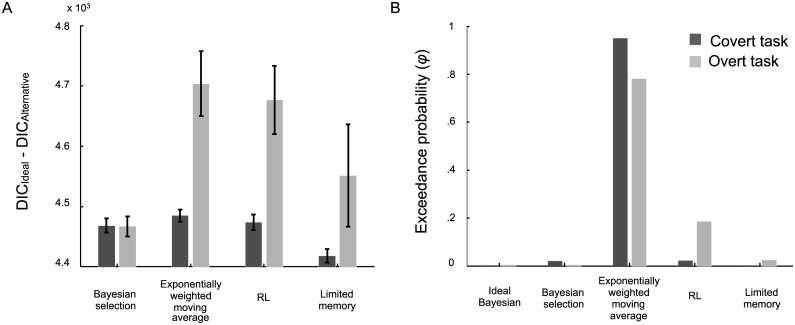
Model comparison results for the covert- (dark gray) and overt-criterion (light gray) tasks in Expt. 1.A) The bar graph depicts the relative DIC scores (i.e., DIC difference between the ideal Bayesian model and the suboptimal models) averaged across observers ±SE. Larger values indicate a better fit. B) To summarize the results from the group level analysis we computed exceedance probabilities for each model in each task. A model’s exceedance probability tells us how much more likely that model is compared to the alternatives, given the group data.